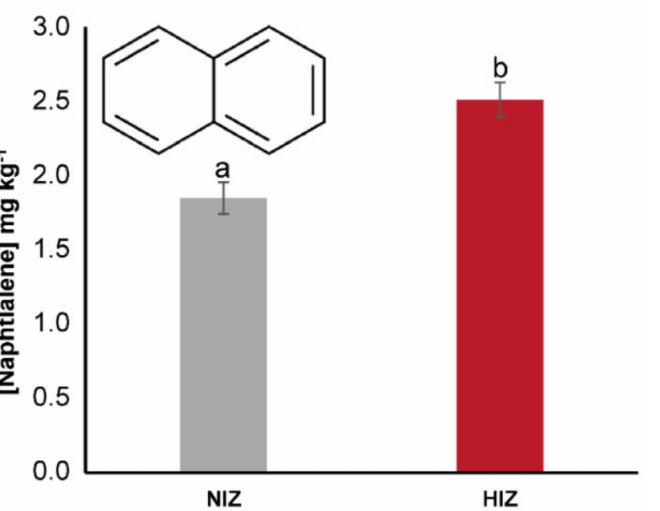
Figure 3. Concentration of naphthalene (NAF) in Macrocystis pyrifera tissue from Algarrobo (NIZ) and Caleta Horc ó n (HIZ) after 60 days of culture. Letters (a and b) correspond to significant differences, ANOVA ( p < 0.05). Each treatment comprised three replicates. NIZ = non-impacted zone, HIZ = highly impacted